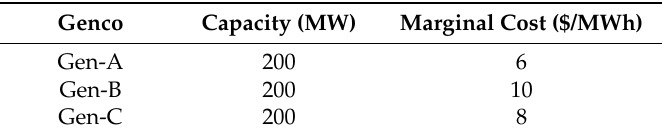
Figure 2. Three-node test system. Table 1. Generation data of Gencos (capacity, marginal cost).